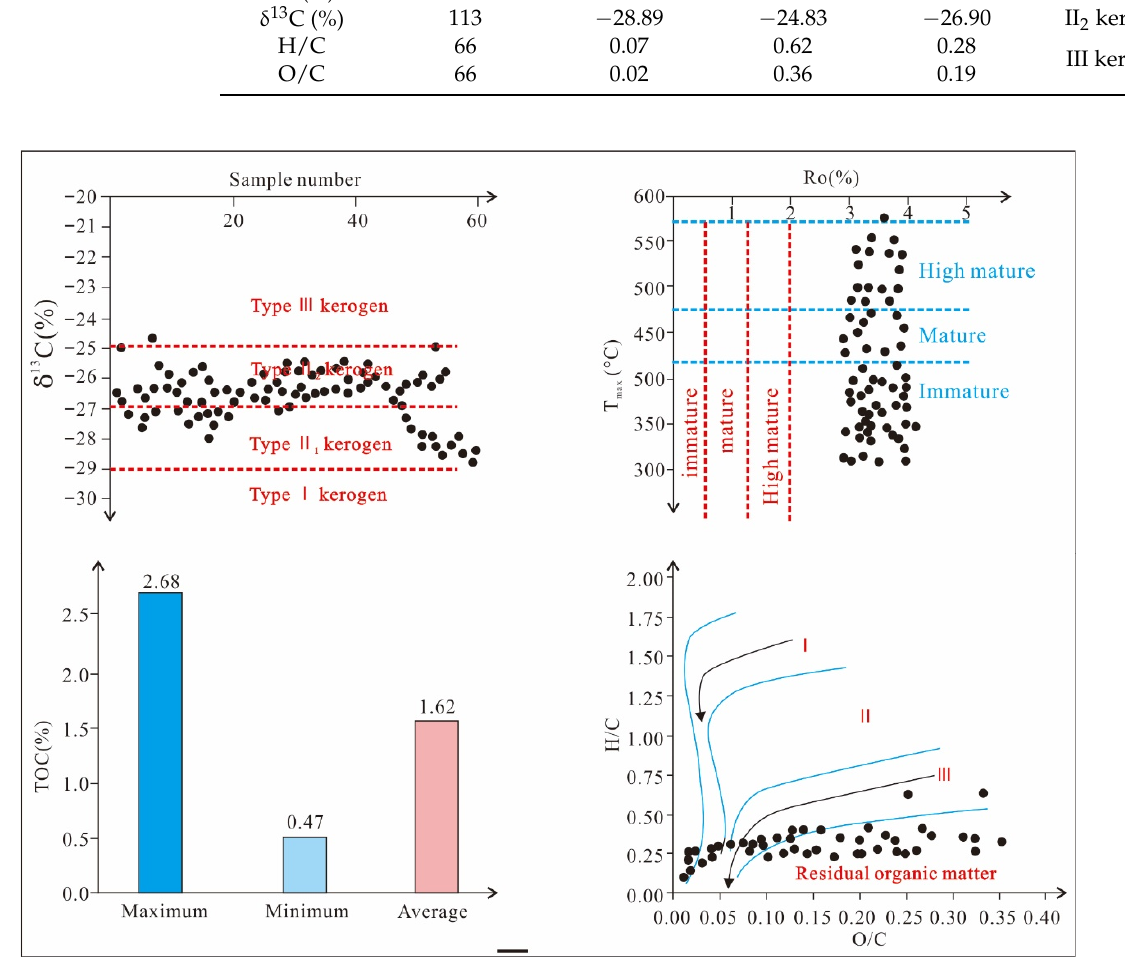
Figure 4. Organic geochemical parameters of the Galedesi Formation shale.